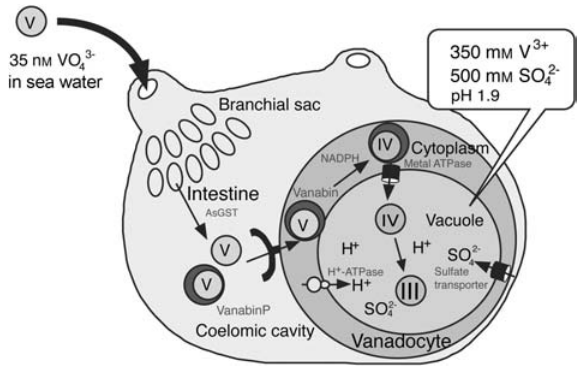
Figure 3 Schematic representation of vanadium accumulation and reduction in